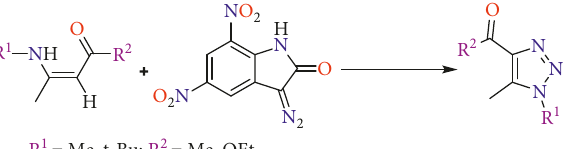
Scheme 7: Synthesis of 1,2,3-triazoles from 3-Diazo-1,3-Dihydro-2H-Indol-2-one Derivatives with Enaminones.